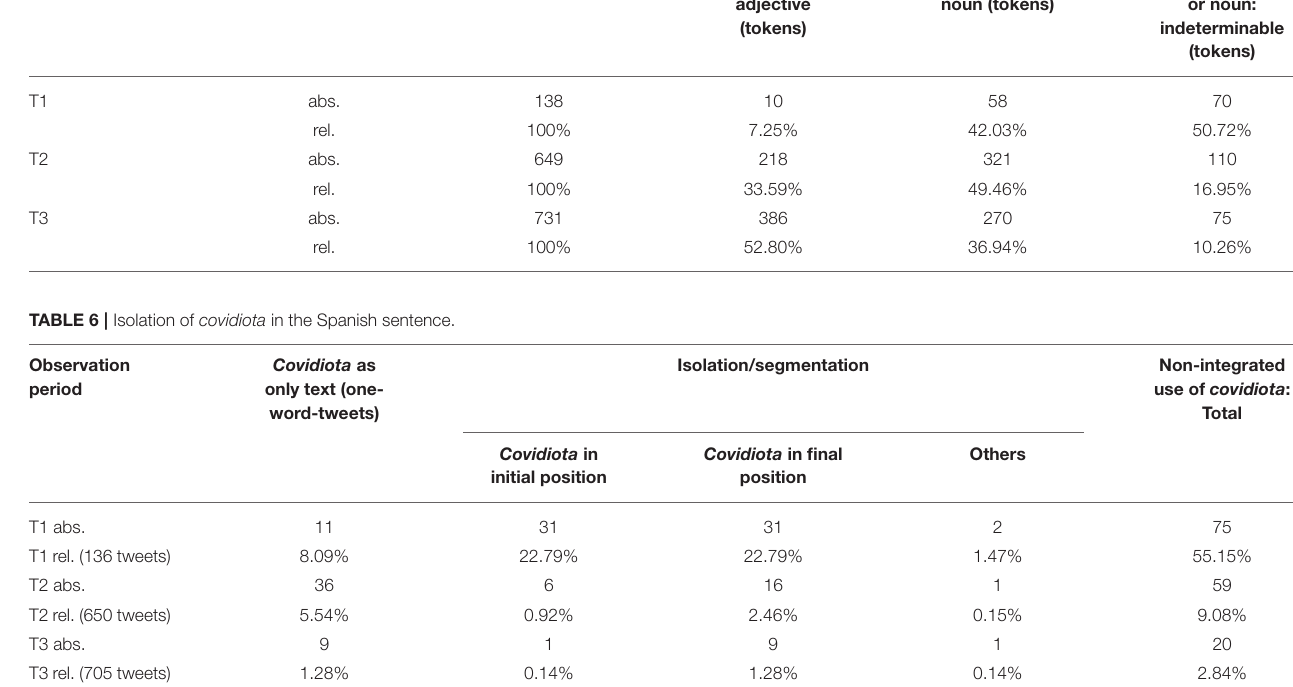
TABLE 5 | Parts of speech – covidiota as adjective or noun in the corpus. Observation period